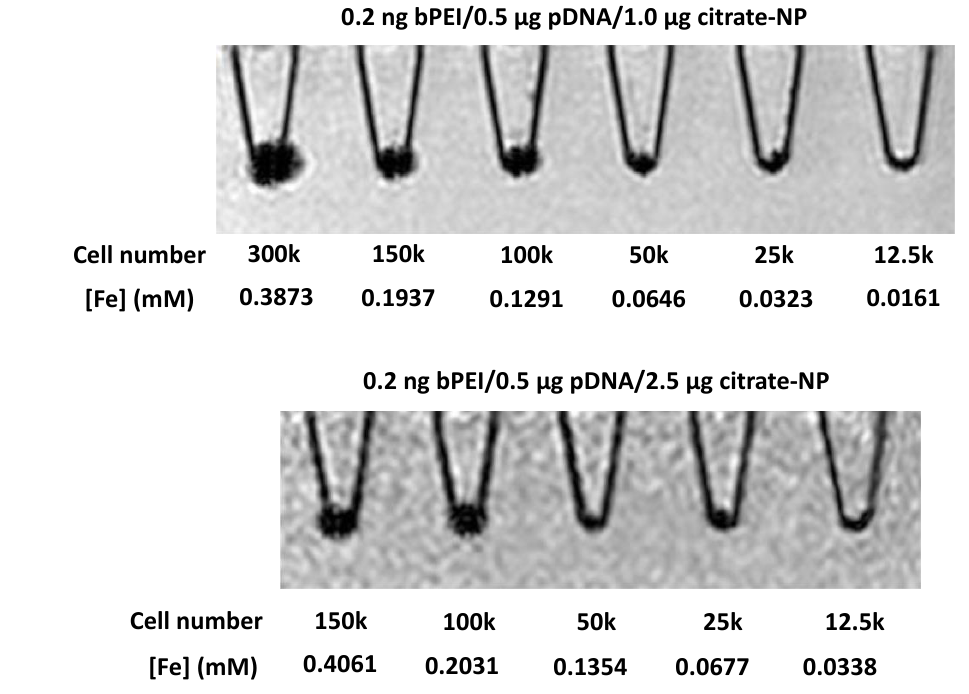
Figure 2. Gradient echo in vitro MRI images of the two composites (0.2 ng branched bPEI/0.5 μg pEGFP-C1 pDNA/1.0 μg citrate-NP and 0.2 ng branched bPEI/0.5 μg pEGFP-C1 pDNA/2.5 μg citrate-NP)-transfected U87MG cells in Eppendorf tubes with culture medium.